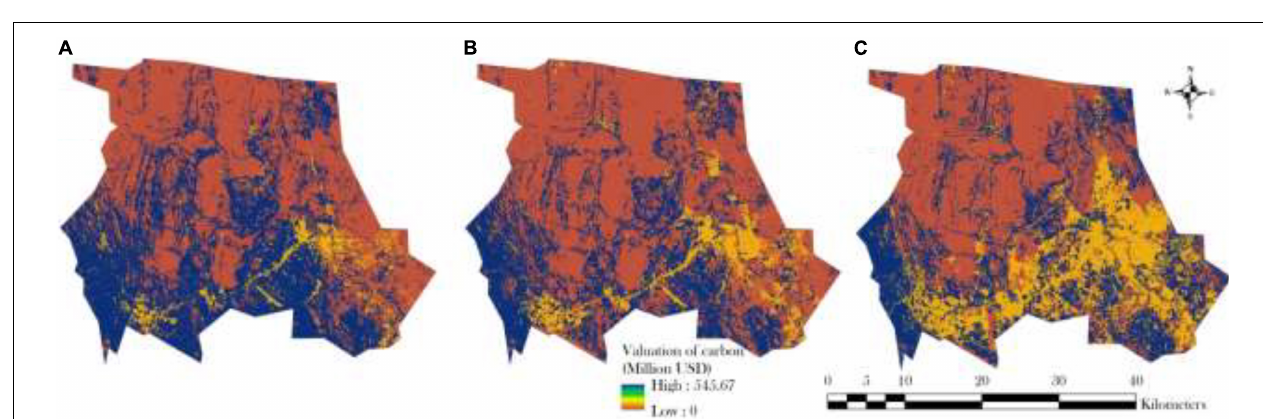
FIGURE 6 | Carbon storage modeling with InVest software for (A) 1990, (B) 2000, and (C) 2020.